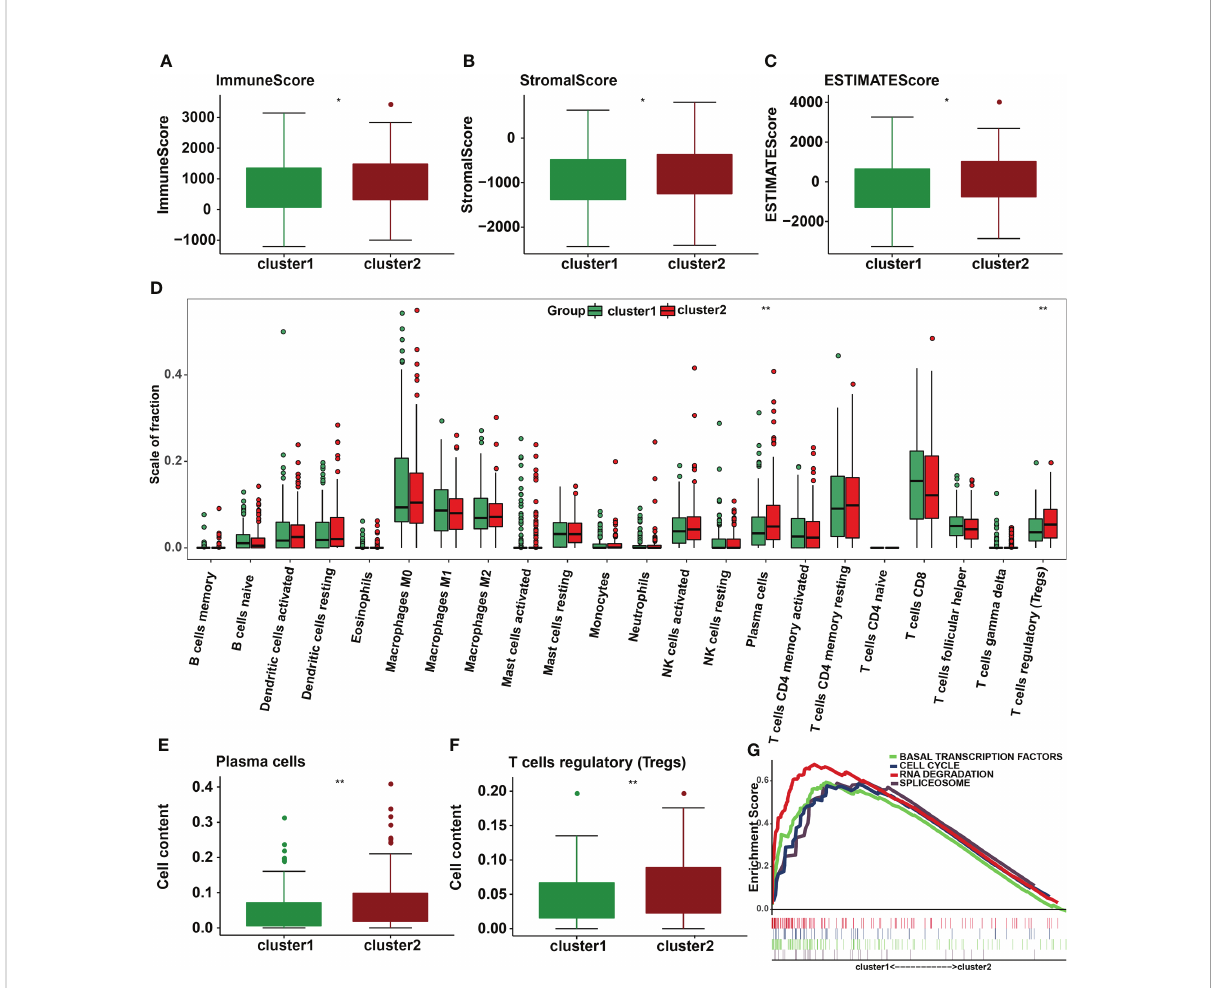
FIGURE 6 Differences in the level of immune cell in fi ltration between the two clusters in cervical cancer and the biological pathways involved. (A) Immunescore, (B) stromalscore, and (C) estimatescore in the cluster 1/2 subtypes. (D) The in fi ltrating levels of 22 immune cell types in cluster 1/ 2 in cervical cancer. (E) The in fi ltrating levels of the plasma cells and (F) regulatory T cells in two clusters. * p < 0.05; ** p < 0.01. (G) GSEA shows signaling pathways involved in cluster